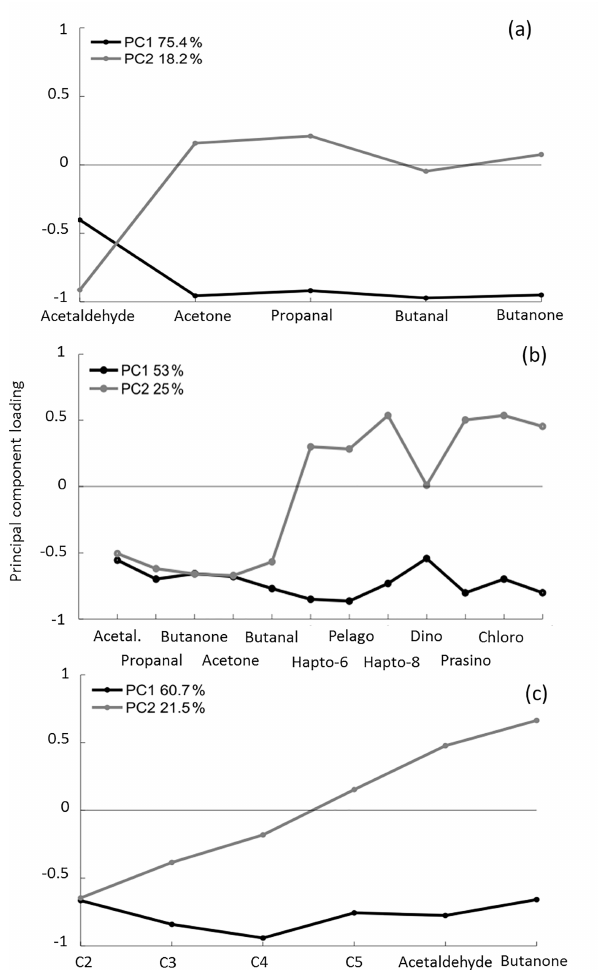
Figure 3. Principal component analysis (PCA) of OVOCs in sea- water (a) ; between OVOCs in seawater and phytoplankton (b) ; and between fluorescent dissolved organic matter (FDOM) groups, acetaldehyde and butanone in seawater (c) . Numbers on the y axes indicate the factor loadings of each variable of each prin- cipal component (PC). The percentages show the explained vari- ability in the dataset by each PC. Hapto-6: haptophytes, mainly coccolithophorids; Pelago: pelagophytes; Hapto-8: haptophytes, mainly Phaeocystis sp.; Dino: dinoflagellates; Prasino: prasino- phytes; Chloro: